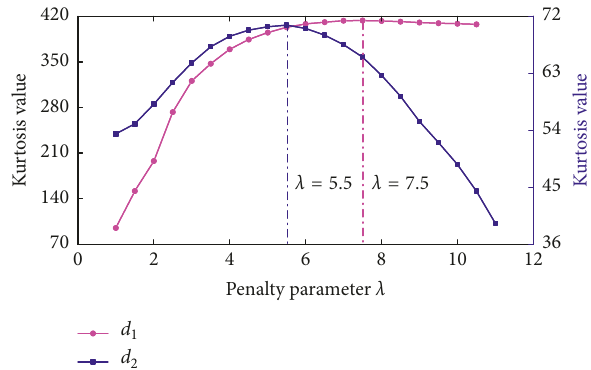
Figure 10: Envelope spectra kurtosis for different values of reg- ularization parameter for Case 2.